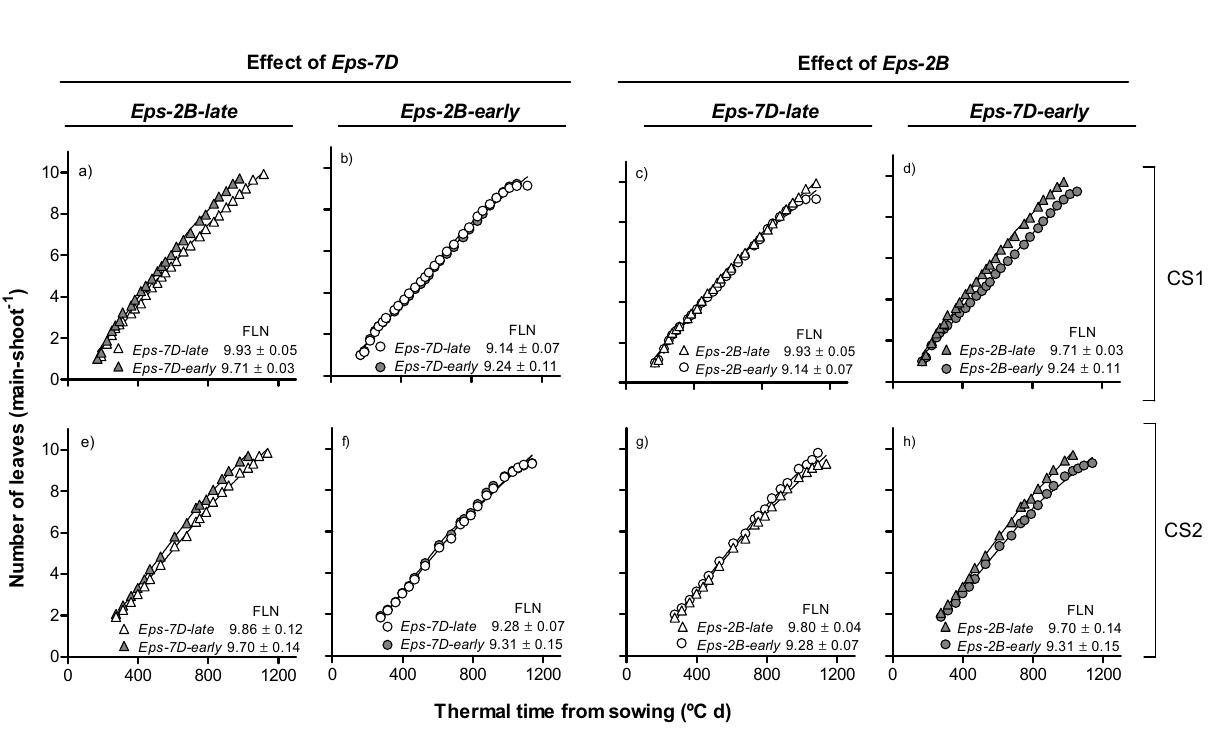
Figure 3. Relationship between number of leaves appeared on the main shoot and thermal time from sowing as affected by Eps-7D (left panels: a , b , e , f ) and Eps-2B genes (right panels: c , d , g , h ) on backgrounds contrasting in the allelic form of the other Eps gene (left and right panels within each Eps gene) in cropping seasons 1 (top panels: a – d ) and 2 (bottom panels: e – h ). Inside each of the panels are the final leaf number (FLN) with their